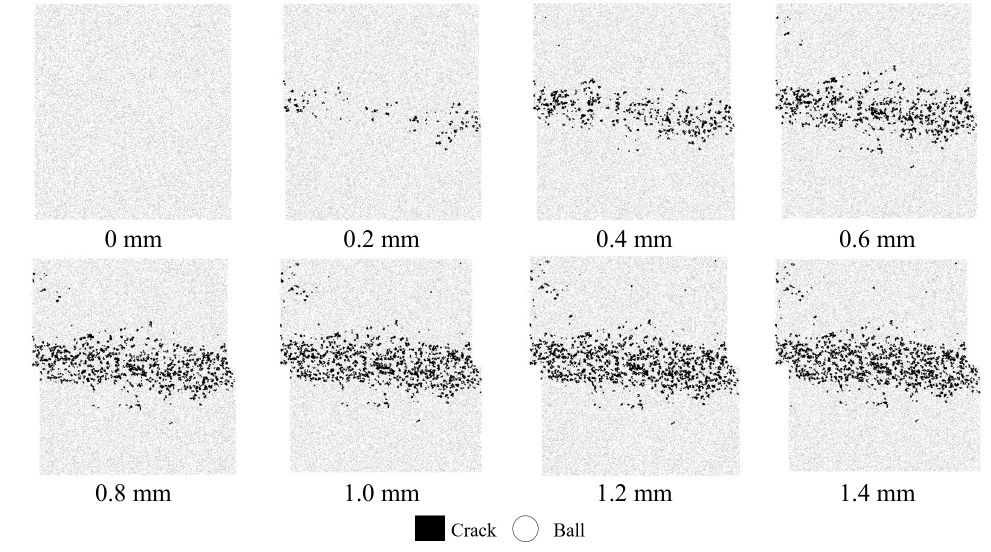
Figure 18. In direct shear test, crack propagation nephogram of natural gas hydrate deposits with normal stress of 1.2 MPa and saturation of 30%.